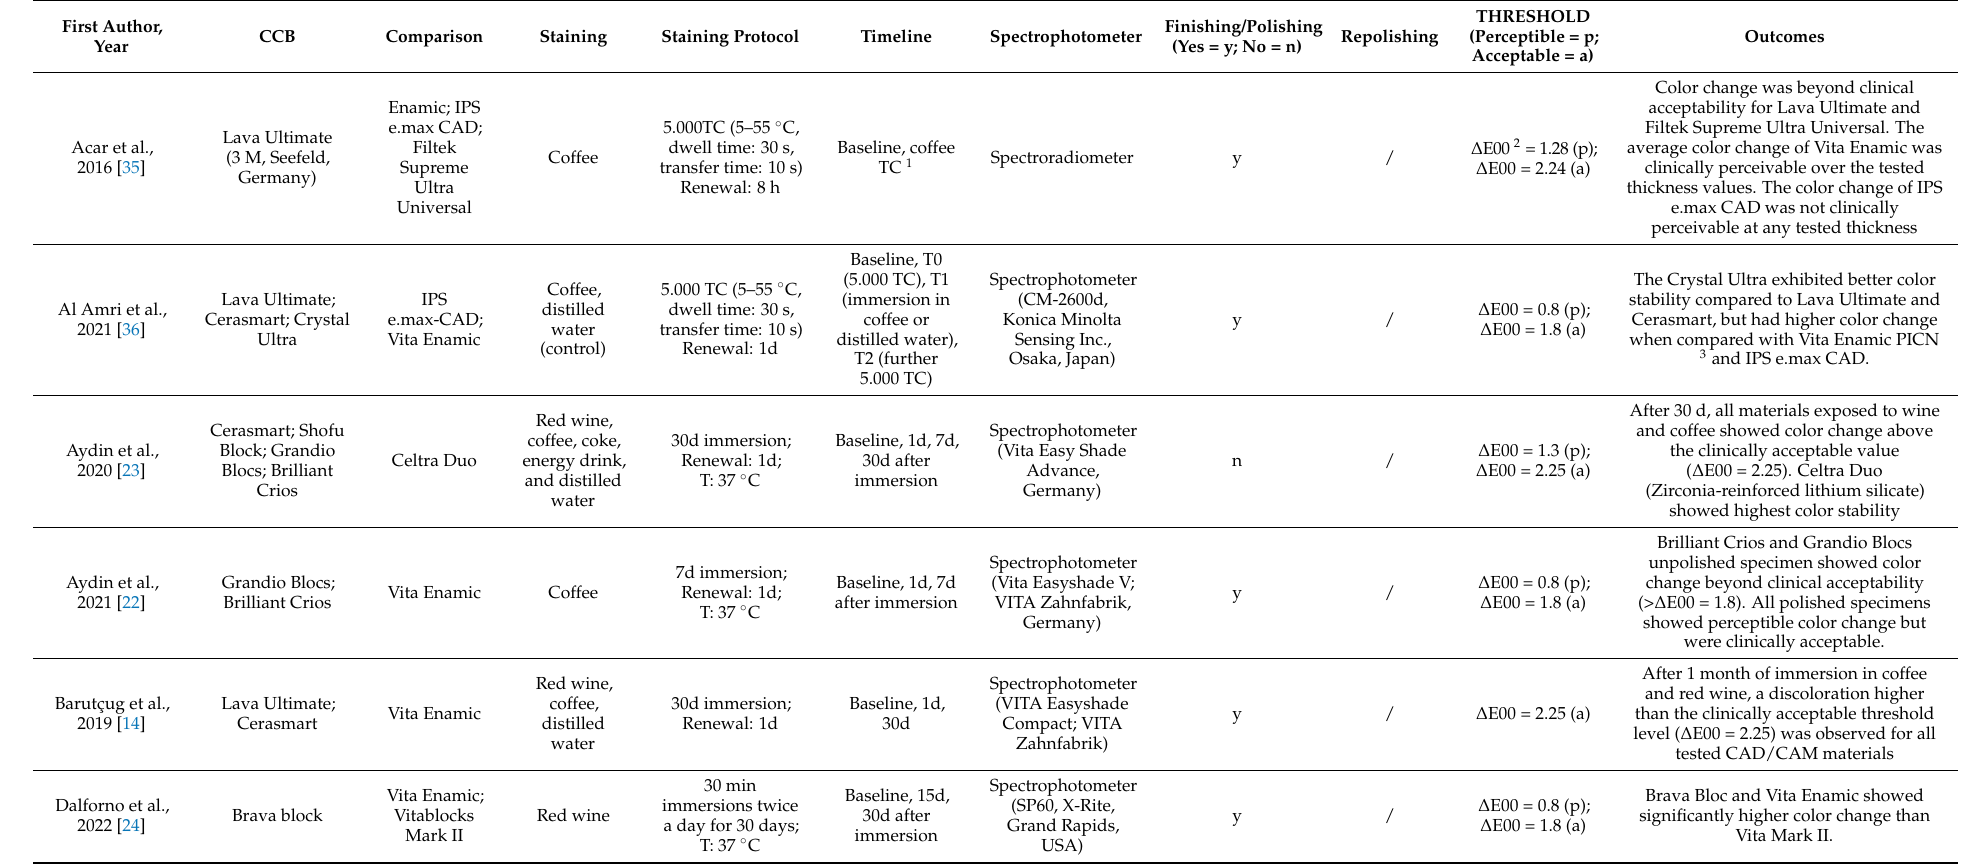
Table 3. List of the in vitro studies included in the review after the screening process. CCB: CAD/CAM composite block; TC: thermocycling. (1: TC= thermocycling; 2: ∆ E00= color change obtained with CIEDE2000 formula; 3: PICN= polymer infiltrated ceramic network; 4: ∆ E= color change value obtained with CIELAB